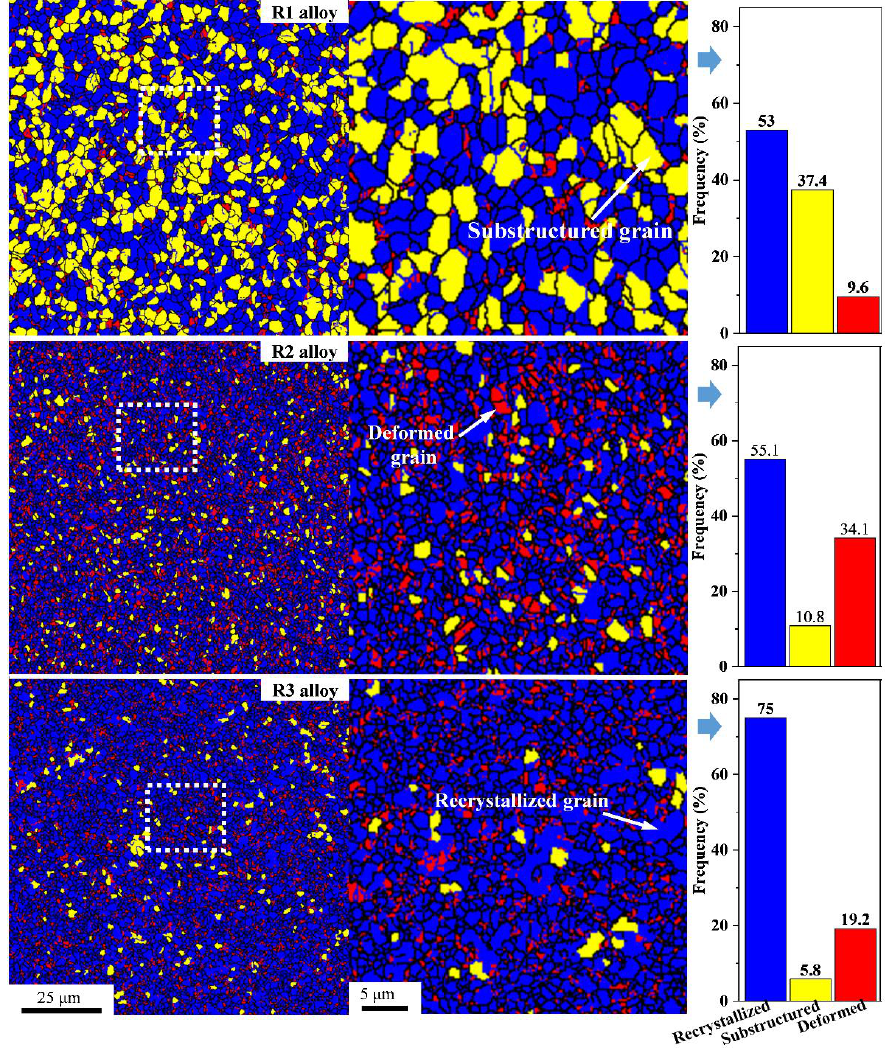
Figure 6. Grain boundary distribution and grain distribution composition of R1, R2, and R3 alloys.